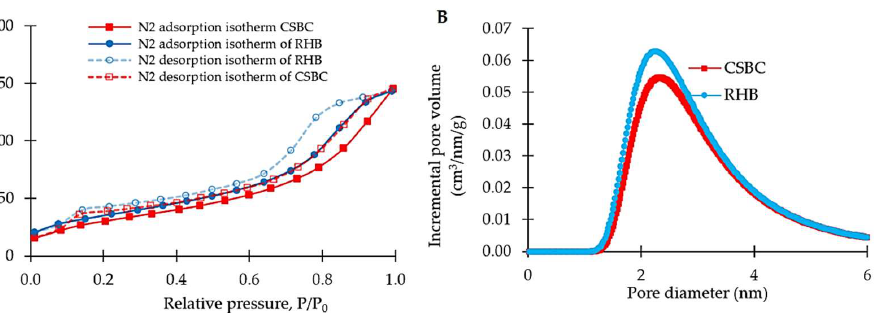
Figure 2. Nitrogen adsorption–desorption isotherms at 77 K ( A ) and pore size distribution ( B ) of RHB and CSBC.